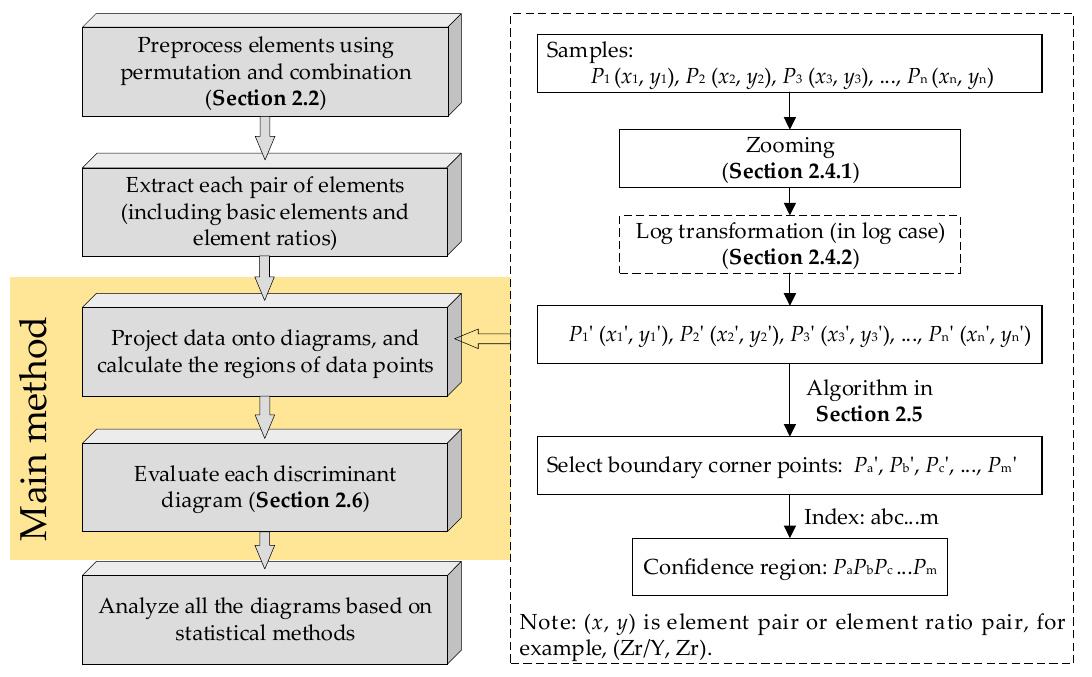
Figure 1. Illustration of the proposed method.